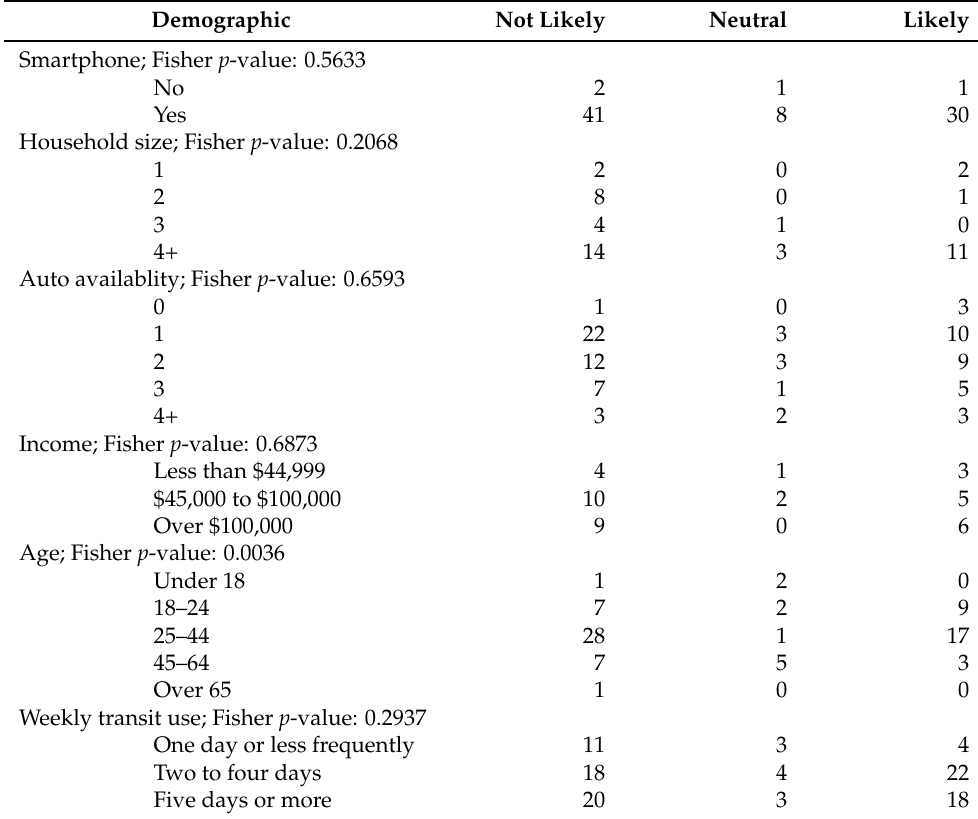
Weekly transit use; Fisher p -value: 0.2937 One day or less frequently